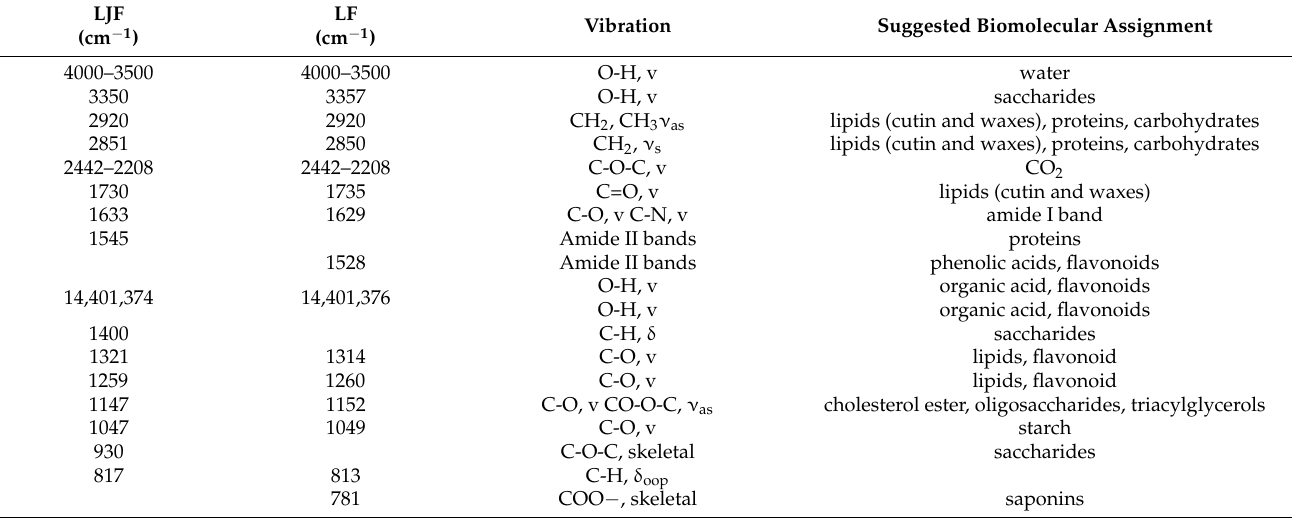
Table 1. Peak assignments of the ATR-FTIR spectra of LJF and